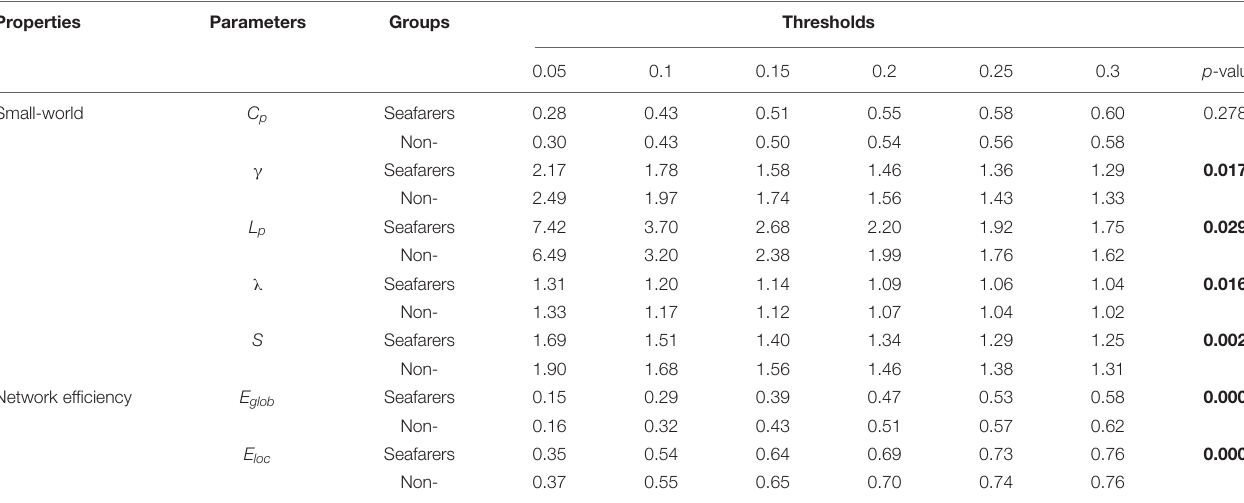
Values in bold indicate statistically significant differences. TABLE 9 | The mean of all network parameters for seafarers and non-seafarers at Len = 90 TRs are presented, as well as the results of two-way ANOVA ( p -value).